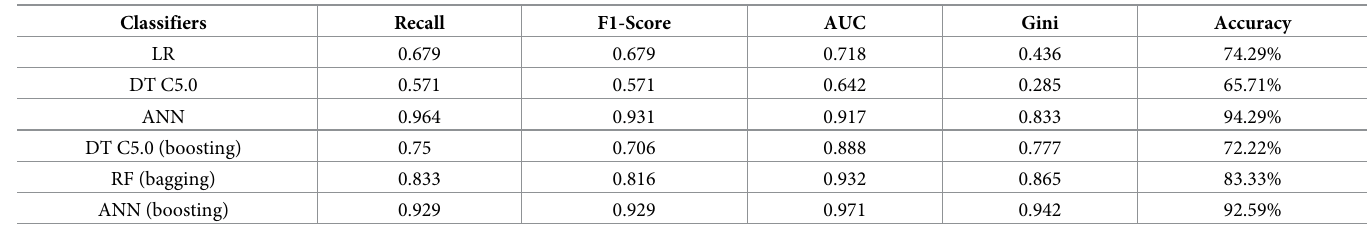
Table 6. Performance comparison of binary classification models with different classifiers.